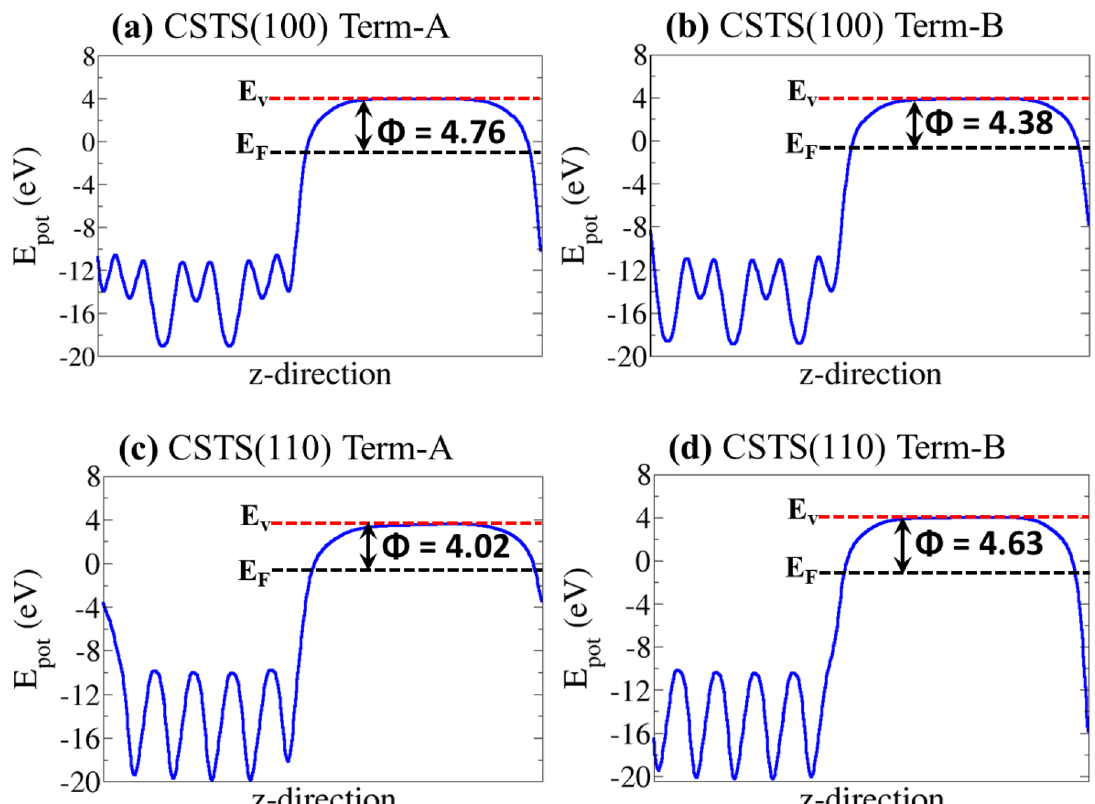
Figure 6. The electrostatic potentials (blue continuous line) for the (100) and (110) surfaces of Cu 2 SrSnS 4 in Termination-A and Termination-B. The red and black dashed lines represent the vacuum level (Ev) and the Fermi level (E F ), respectively. The Φ is the work function.